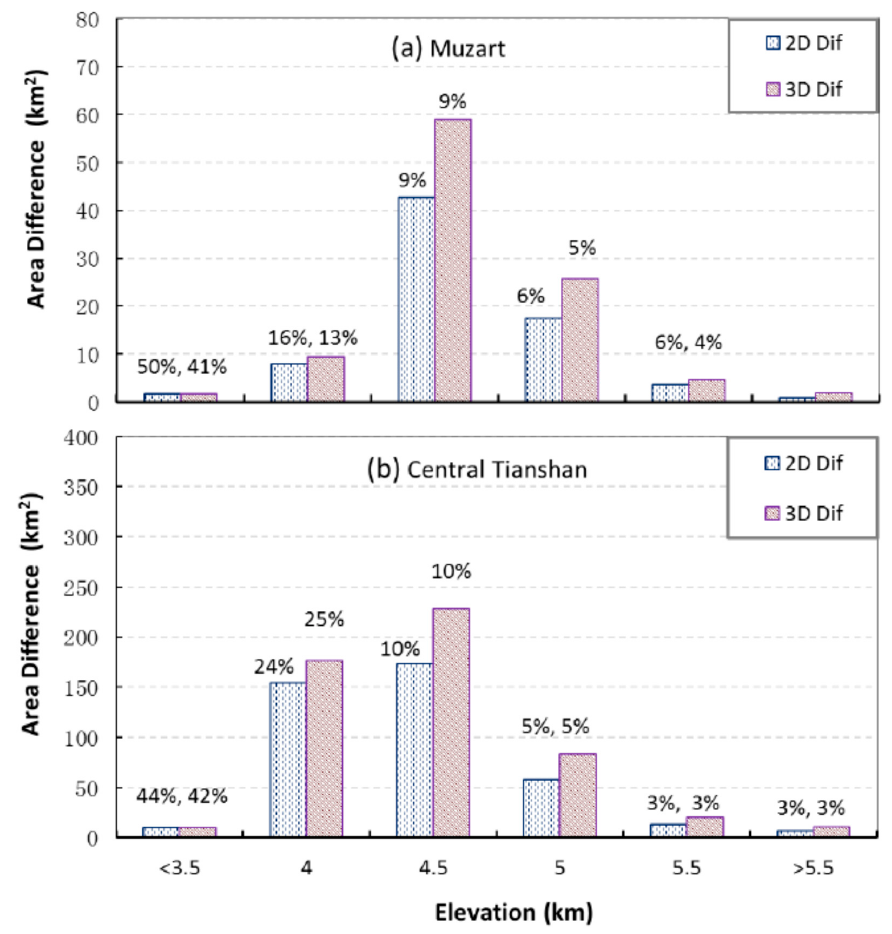
Figure 8. Histogram of Glacier 2D and 3D area difference between 2007 and 2013 (2013 – 2007) in different elevation bands in the Muzart Glacier catchment ( a ) and Central Tianshan ( b ). The numbers above columns are the area shrinking rates ((2013 – 2007)/2007) in each elevation bands.